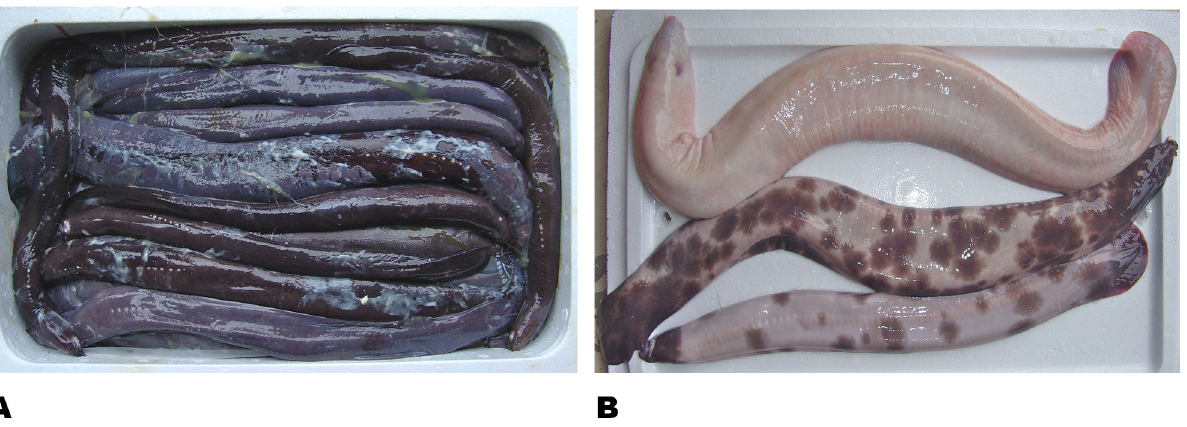
Figure 3. Color variations in Eptatretus cirrhatus. (a) Typical fresh specimens have a solid color ranging from burgundy to a chocolate brown. (b) These are two of three piebald specimens and the only albino animal collected. doi: 10.1371/journal.pone.0078740.g003 difference between the length:weight relationships of males heavier than females at a given length, but the curves were versus females [F =6.359; p<0.05] with males slightly parallel throughout the range of values. (2,341)